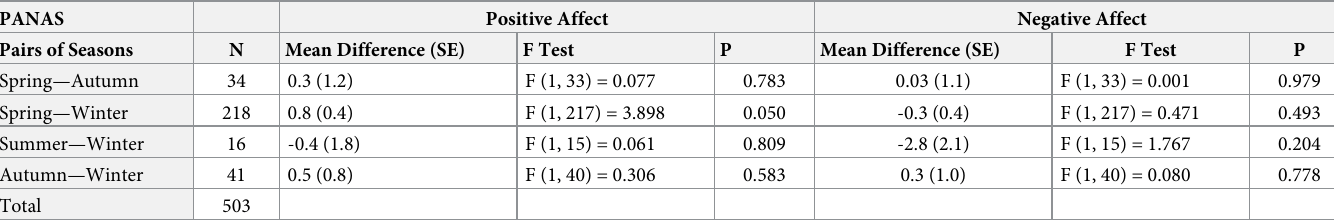
Table 6. Mean difference in positive and negative affect between the seasons in repeated measures.